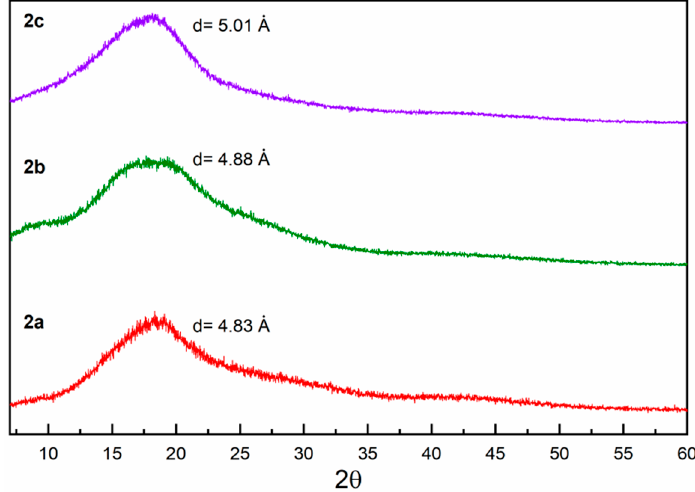
Figure 6. X ‐ ray diffraction patterns of the polymers bearing thiol moieties. Figure 6. X-ray diffraction patterns of the polymers bearing thiol